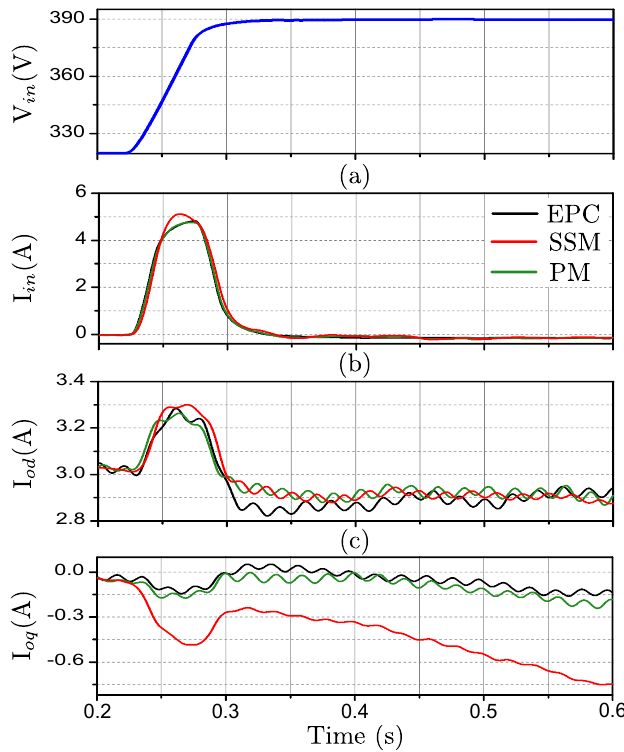
Figure 12. Comparison between ( a ) I in , ( b ) I od and ( c ) I oq of the EPC and the small-signal (SSM) and polytopic models (PM) for a step in V in of 60